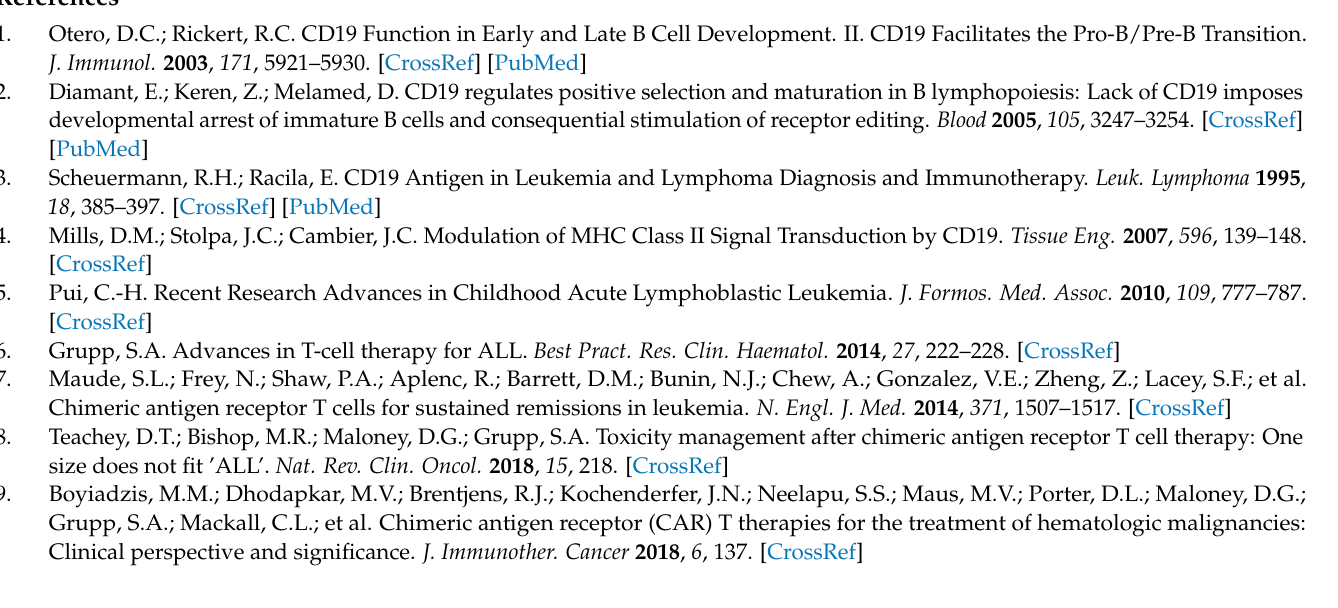
Figure S2: Exosomes reached plateau at 2.5 µ g/ µ L dose. Figure S3: Densitometry of agarose gels by Image J. Figure S4: Expression of cytokines (IFN-g, TNF-a, and IL-2) mRNA by q-PCR. Figure S5: Exo-CD19 CAR effect on CD19 negative and CD19 positive cells. Figure S6: Full image of Figure 2A. Figure S7: Full image of Figure 4A. Figure S8: Full image of Figure 5A (HL-60). Figure S9: Full image of Figure 5B (K-562). Figure S10: Full image of Figure 5C (JM1). Figure S11: Full image of Figure 5D (Sup-B15). Figure S12: Full image of Figure 5E (REH). Figure S13: Full image of Figure 5F